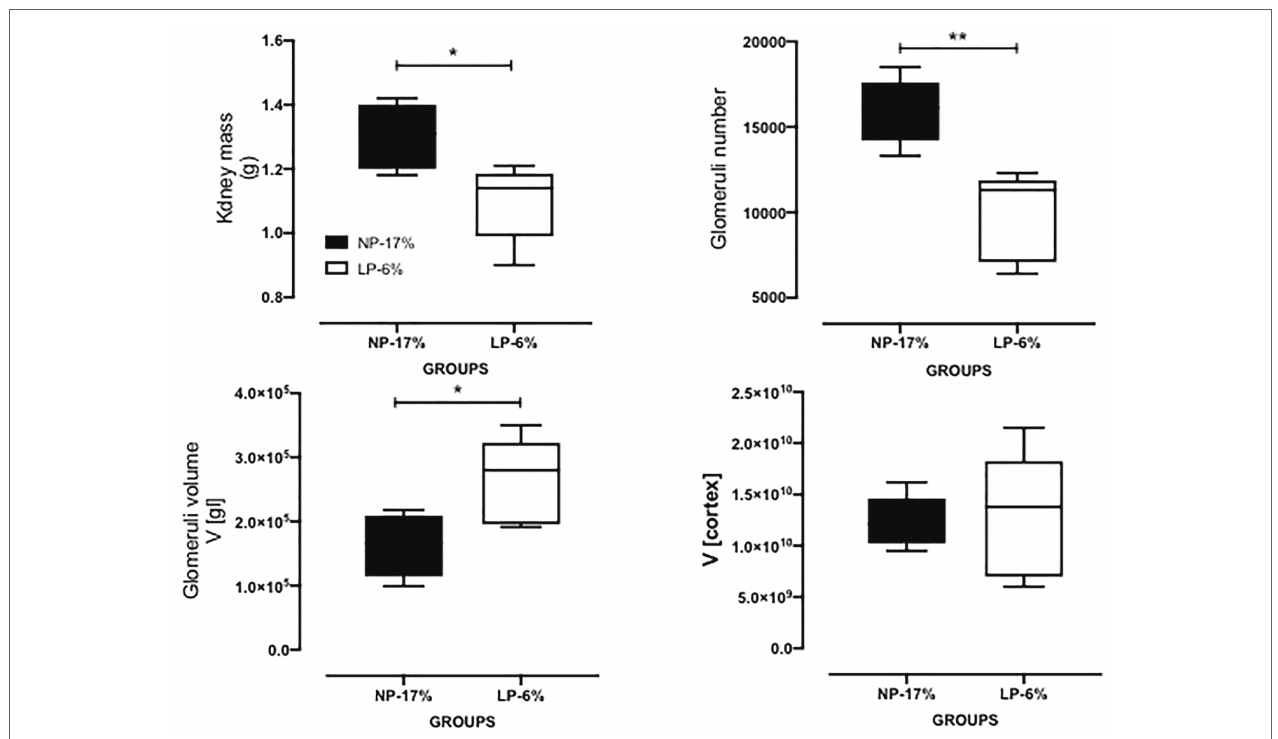
FIGURE 2 | The kidney mass (in grams), glomeruli number and volume, and cortical volume of 24-week-old LP progeny ( n = 5) compared to age-matched NP offspring ( n = 5). Data are presented as scatter dot plots; unpaired Welch’s t -test was used for data analysis. The level of significance was set at * p = 0.01; ** p =